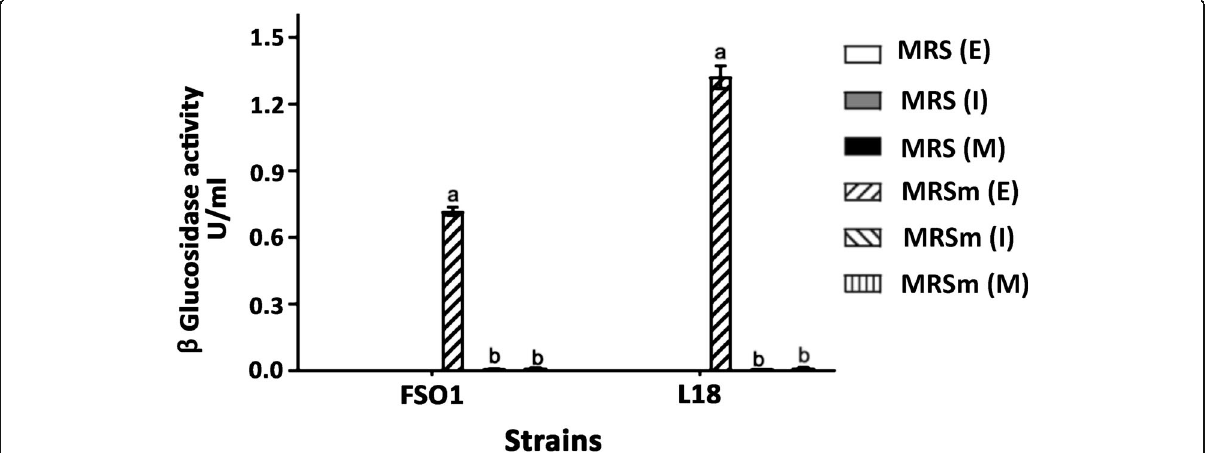
Fig. 2 β -Glucosidase activity of L. plantarum FSO1 and C. pelliculosa L18 obtained after 7 days of culture at 30 °C on MRS and modified MRS (MRSm) containing oleuropein (1%) as a sole carbon source. (Legend: β -glucosidase activity in ( E ): extracellular; ( I ): intracellular and ( M ): parietal fractions)